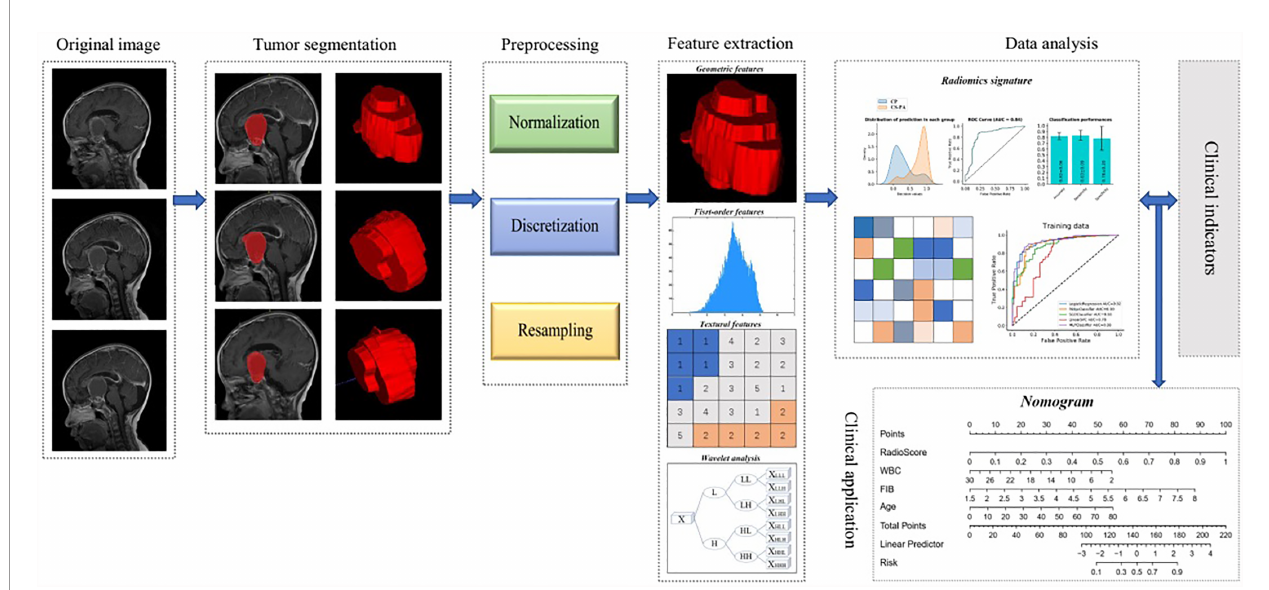
FIGURE 2 | The overall work fl ow of radiomics processing and nomogram